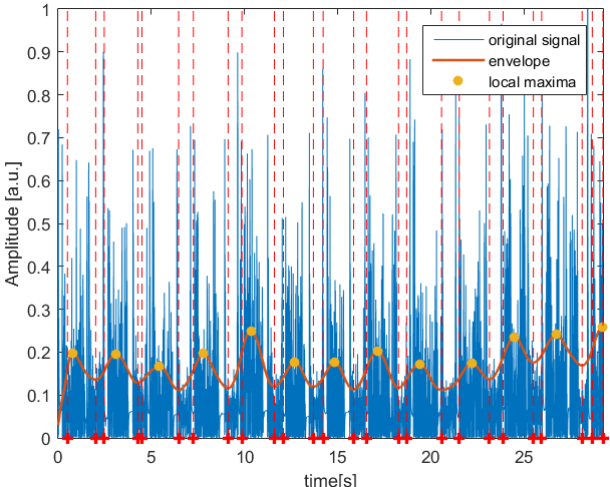
Figure 4. Segmentation result obtained for an example right temporomandibular joint (TMJ) acous- tic signal recorded from healthy patient. The red dashed line corresponds to the beginning and end of every segment.